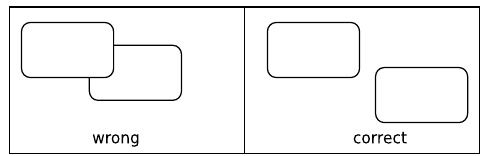
Figure 4.1: Nodes must not overlap.